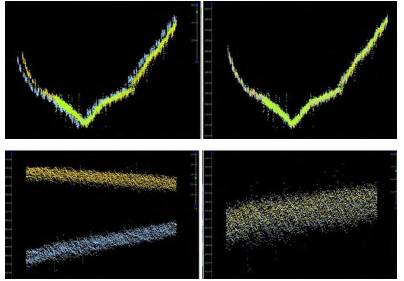
Figure 2. Pitch (above) and roll (below) correction in the calibration